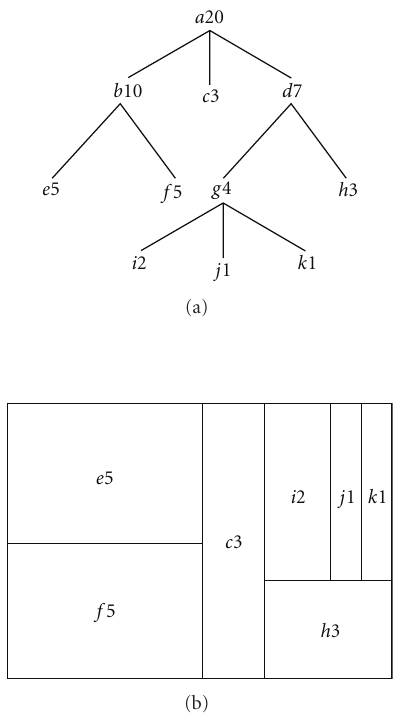
Figure 2: Tree diagram (a) and related treemap (b).